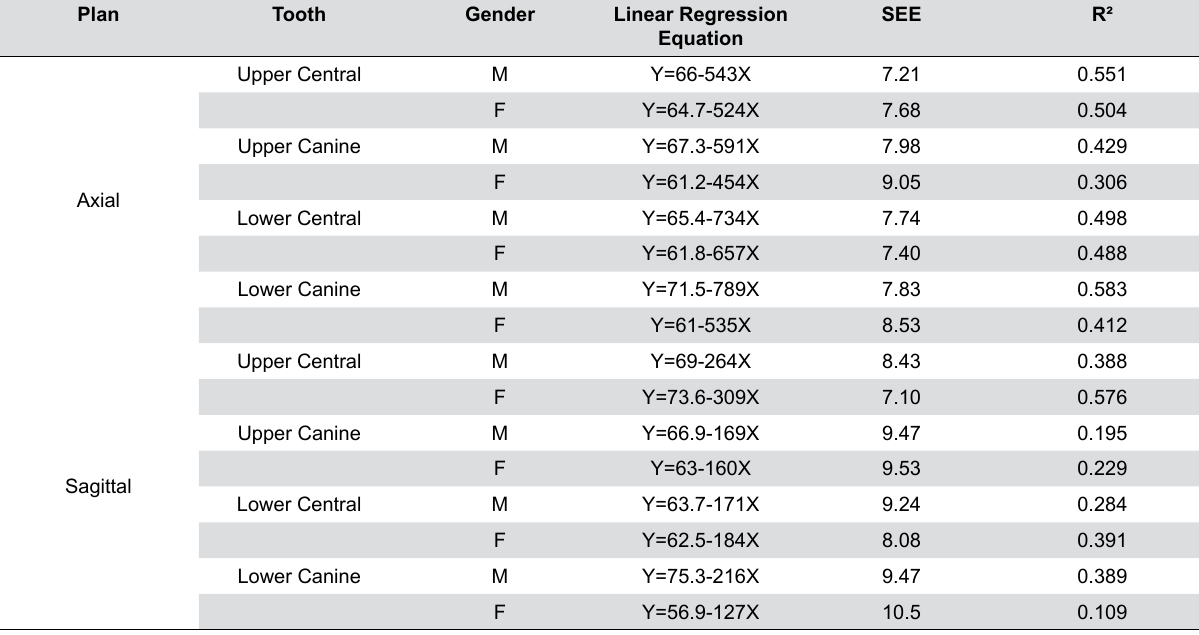
PTR: Pulp to tooth area ratio, r: Correlation coefficient, P: P value. Table 3- Regression models using physiological ratios for predicting chronological